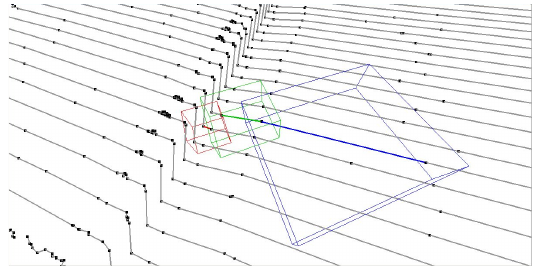
AABB is drawn in red. The AABB of green line segment par- tially overlaps the AABB of the query line segment. Then, it is defined as the neighborhood line segment of the query line seg- ment. But, the blue line segment whose AABB does not intersect to the AABB of the query line segment is not included in the neighborhoods.